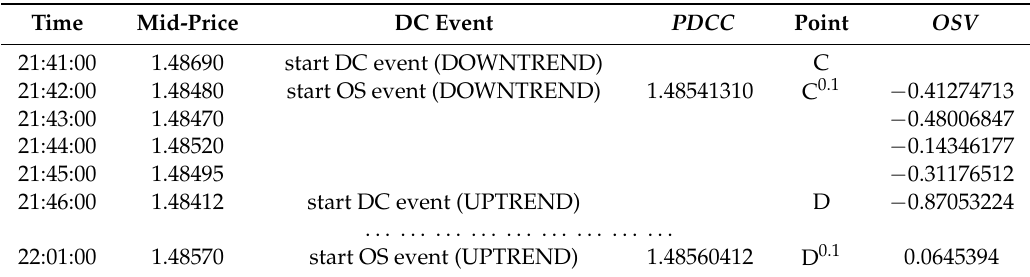
Table 2. An example of a DC summary of GBP/CHF mid-prices sampled minute-by-minute